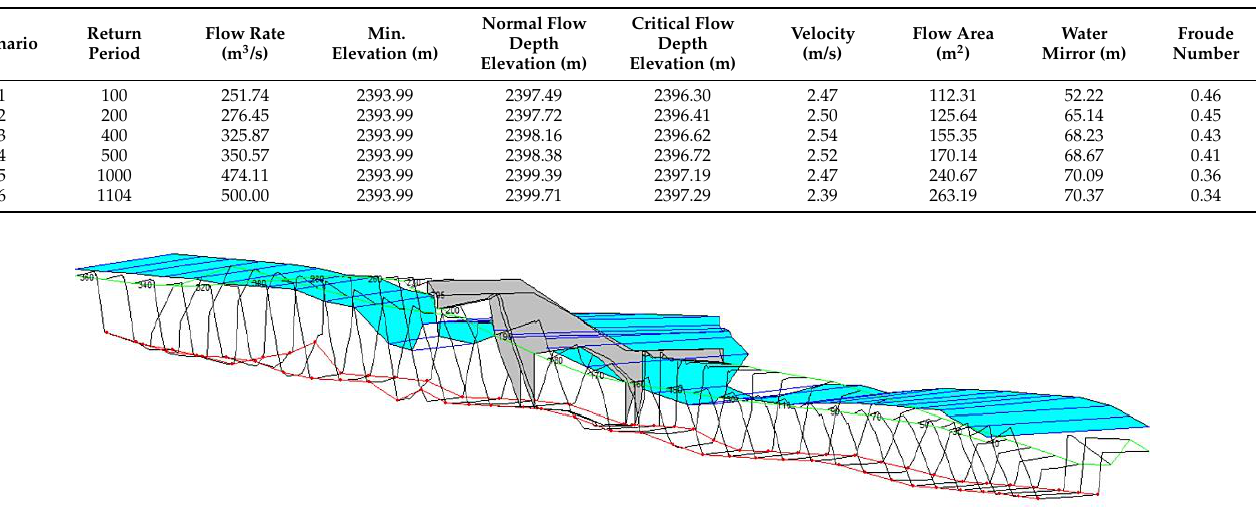
Table 3. Hydraulic simulation results at the bridge cross section.